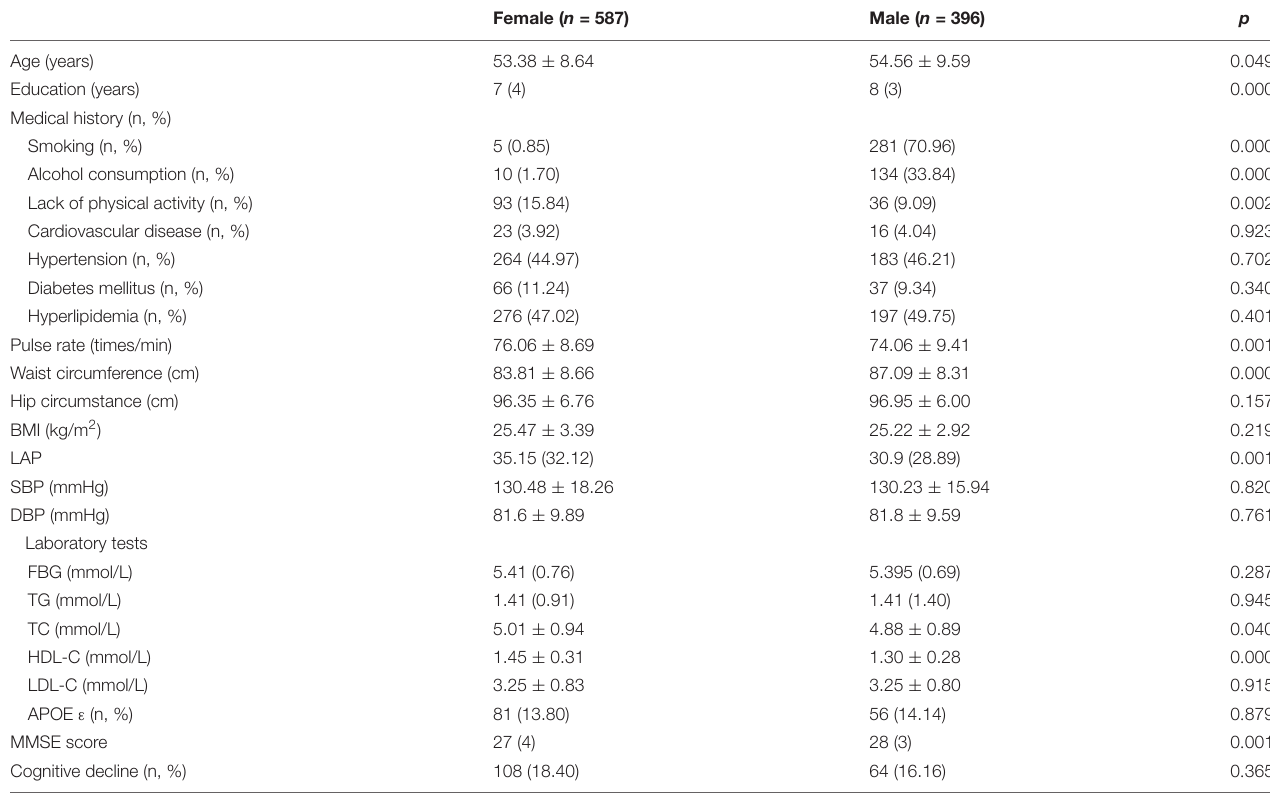
TABLE 4 | Comparison of Female group and Male group in total study